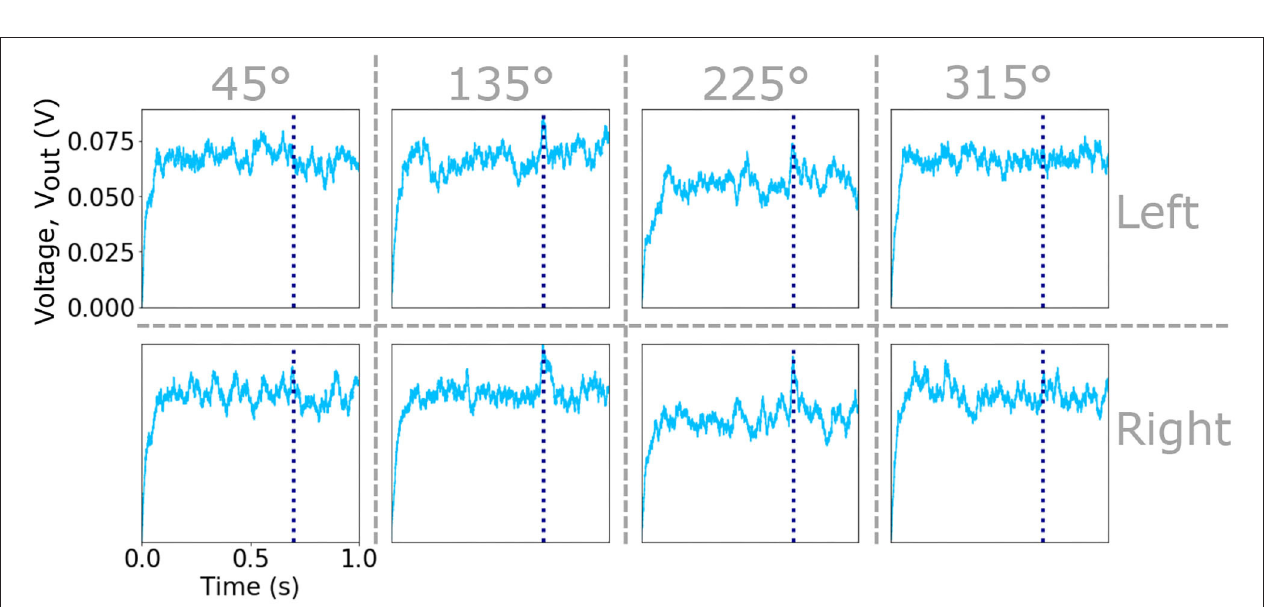
FIGURE 3 | Plots of the V out signal of the eight input neurons that integrate the spikes from eight sub-populations of sensory hairs. The input neurons receiving excitation from the left an right cercus as well as the four preferred directions are indicated by vertical and horizontal dashed lines. Vertical dashed lines within each plot marks the time of an attack during the one second simulation.